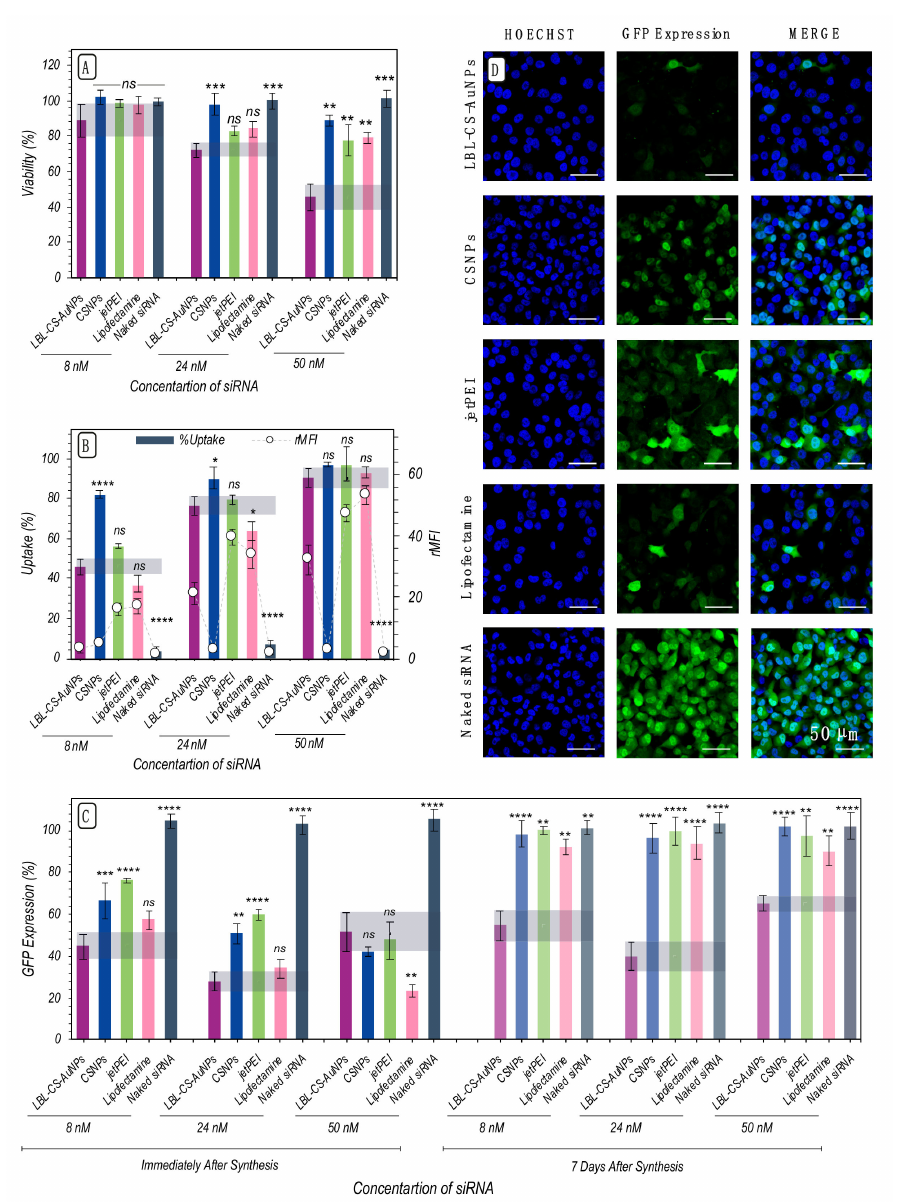
Figure 6. Evaluating the cytotoxicity, uptake and knockdown efficacy of LBL-CS-AuNPs and CSNPs in comparison with jetPEI ® and Lipofectamine as commercial transfection reagents for siRNA . ( A ) Cell viability was measured by CellTiter GLO assay after 4 h incubation with the different carriers at three effective siRNA concentrations (8 nM, 24 nM, and 50 nM). ( B ) Uptake percentage (= % pos-itive cells) and relative mean fluorescence intensities of AF647 siRNA labeled carriers on H1299-eGFP cells were determined by flow cytometry. ( C ) Percentage of eGFP expression on H1299- eGFP cells treated with the different carriers at three effective siRNA concentrations (8 nM, 24 nM, and 50 nM) for both freshly and 7 days after synthesis. ( D ) Confocal images of H1299-eGFP cells after treatment with different carriers at 24 nM effective concentration of siRNA. The nuclei stained with Hoechst 33,342 are shown in blue and the eGFP expression is shown in green in the fluorescence images. The scale bars correspond to 50 µ m. Data are represented as mean ± the standard error of the mean for a minimum of three independent experiments. Statistical signifi-cance, with respect to LBL-CS-AuNPs, is indicated when appropriate (ns = not significant p > 0.05, * p ≤ 0.05, ** p ≤ 0.01, *** p ≤ 0.001, **** p ≤